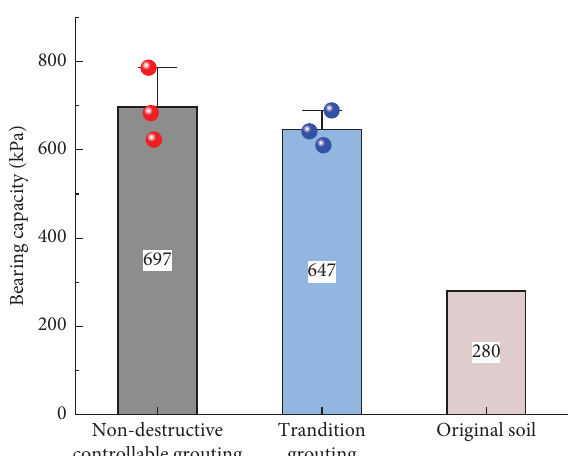
Figure 5: Comparison of bearing capacity.